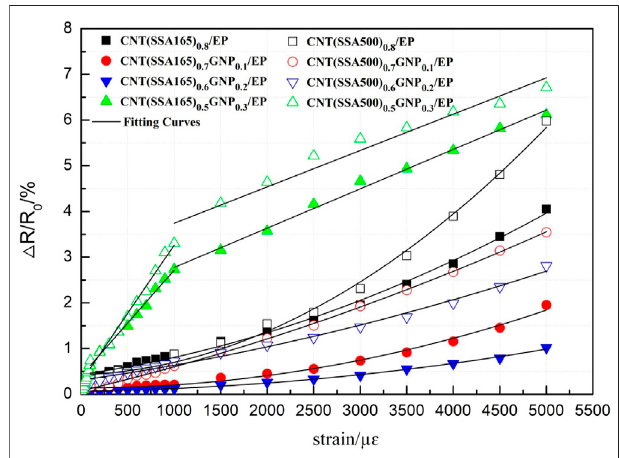
FIGURE 6 | Strain-electrical resistance response